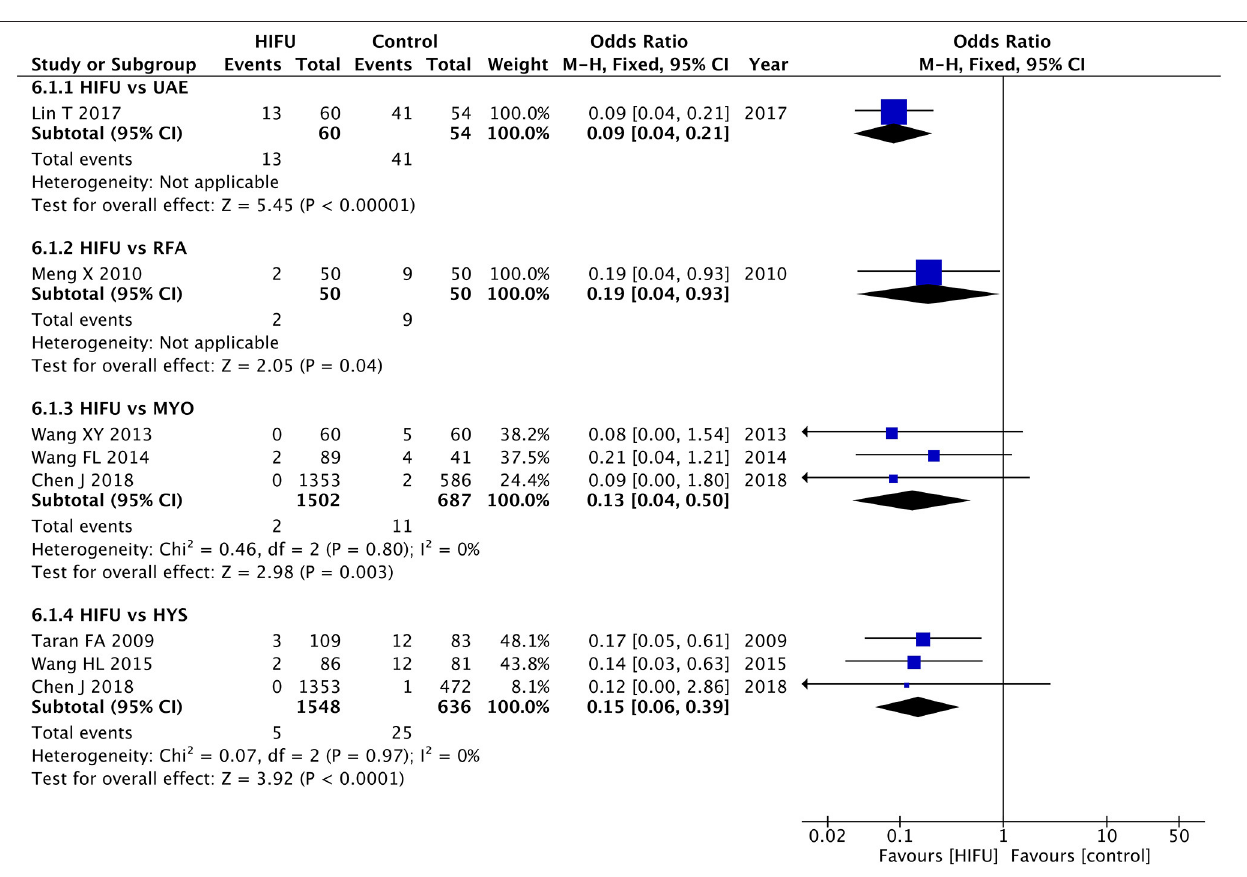
Frontiers in Oncology |